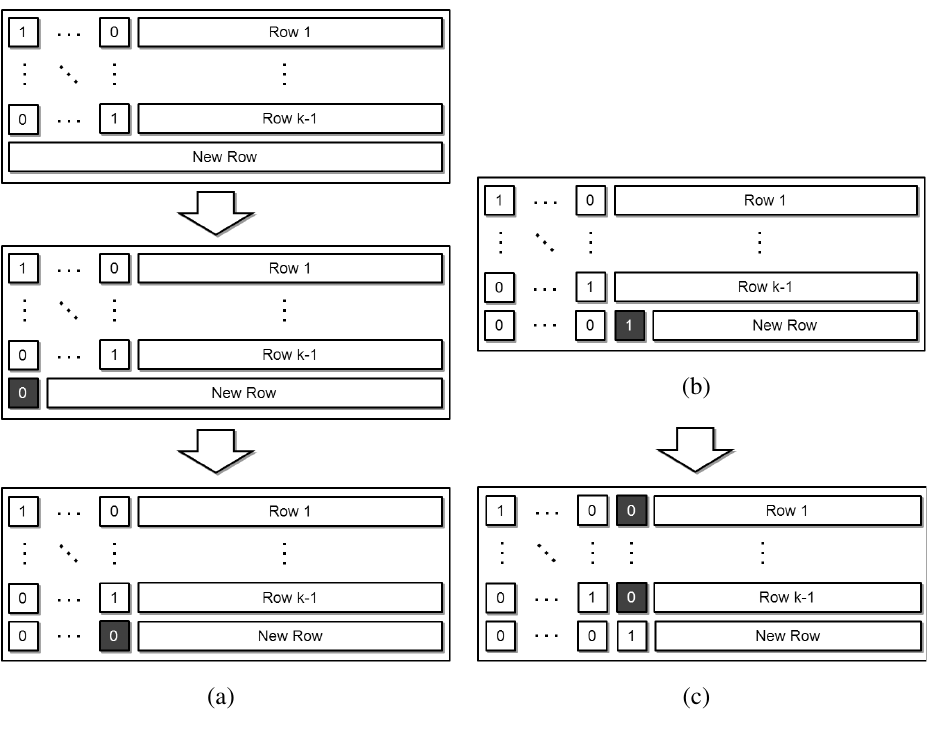
Table 1. Five Stages of Progressive Decoding